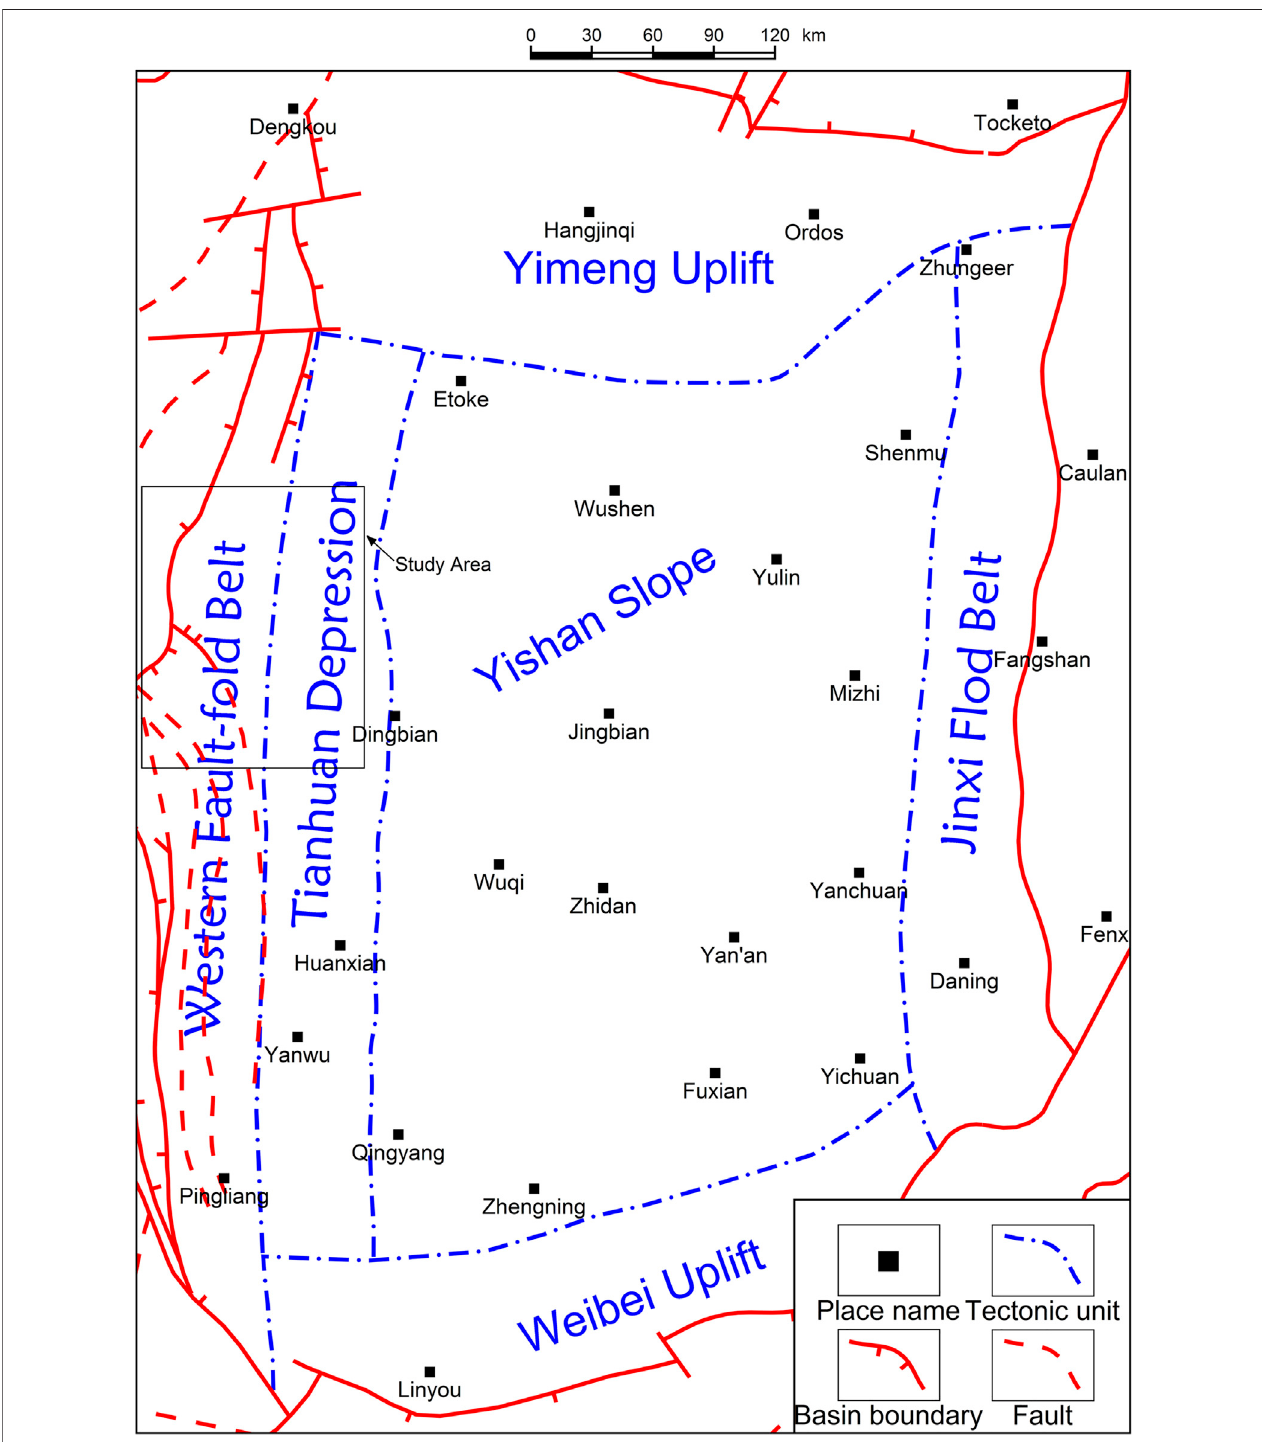
FIGURE 1 | Tectonic unit and location of the study area in the Ordos Basin.